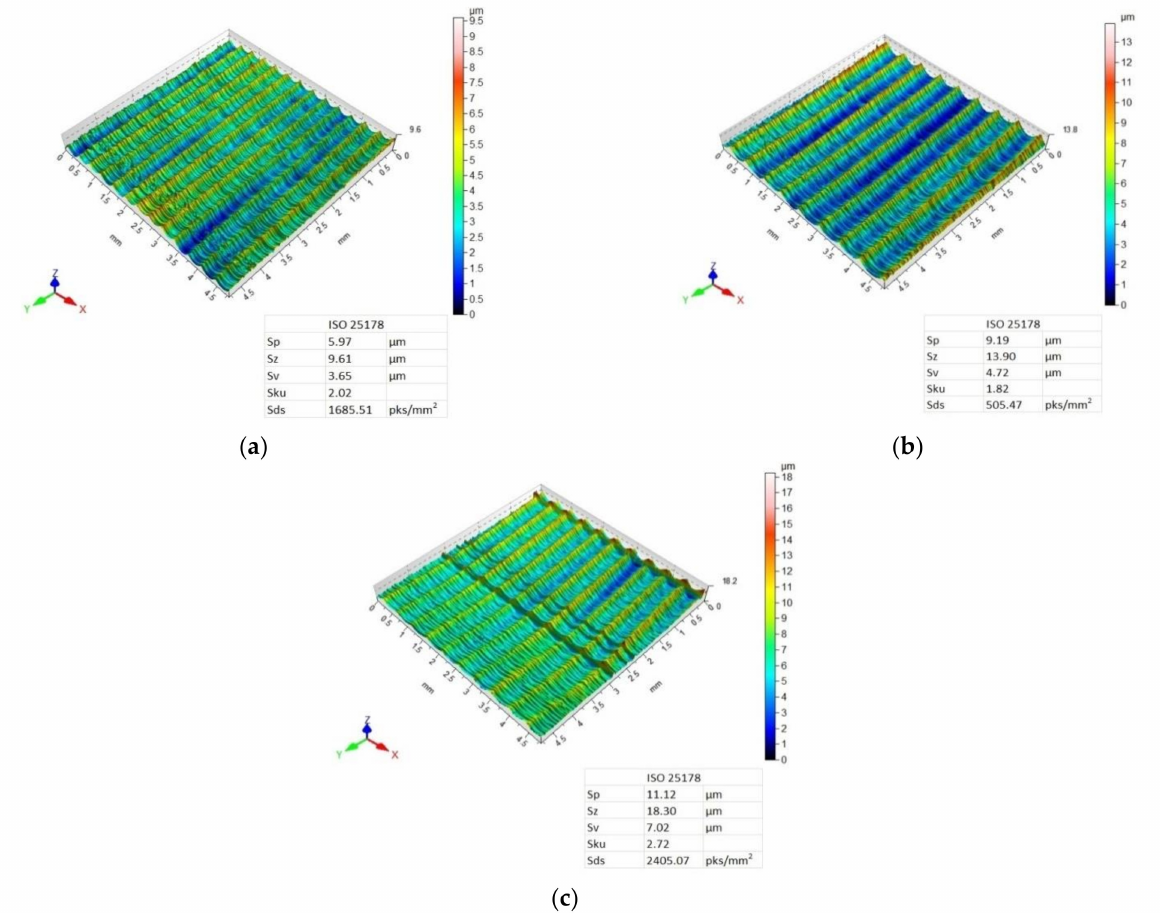
Figure 7. Surface topography of aluminium alloy after milling using Al/CFRP strategy and feed rate: ( a ) f z = 0.04 mm/blade, ( b ) f z = 0.08 mm/blade, ( c ) f z = 0.12